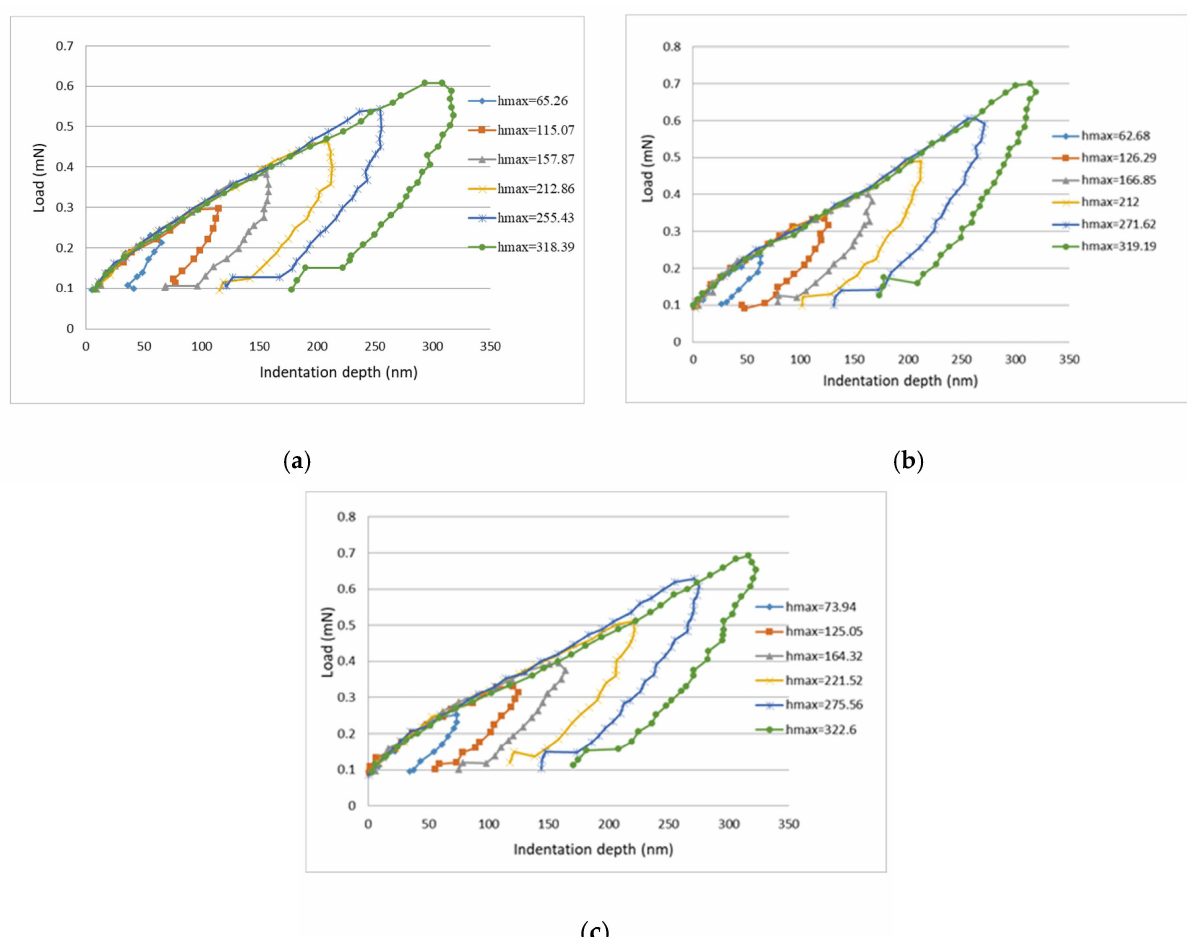
Figure 9. Load vs. indentation depth curves for nanocomposite films. ( a ) neat epoxy ( b ) nanocomposite reinforced with 0.3 wt % GNP, ( c ) nanocomposite reinforced with 0.8 wt % GNP.